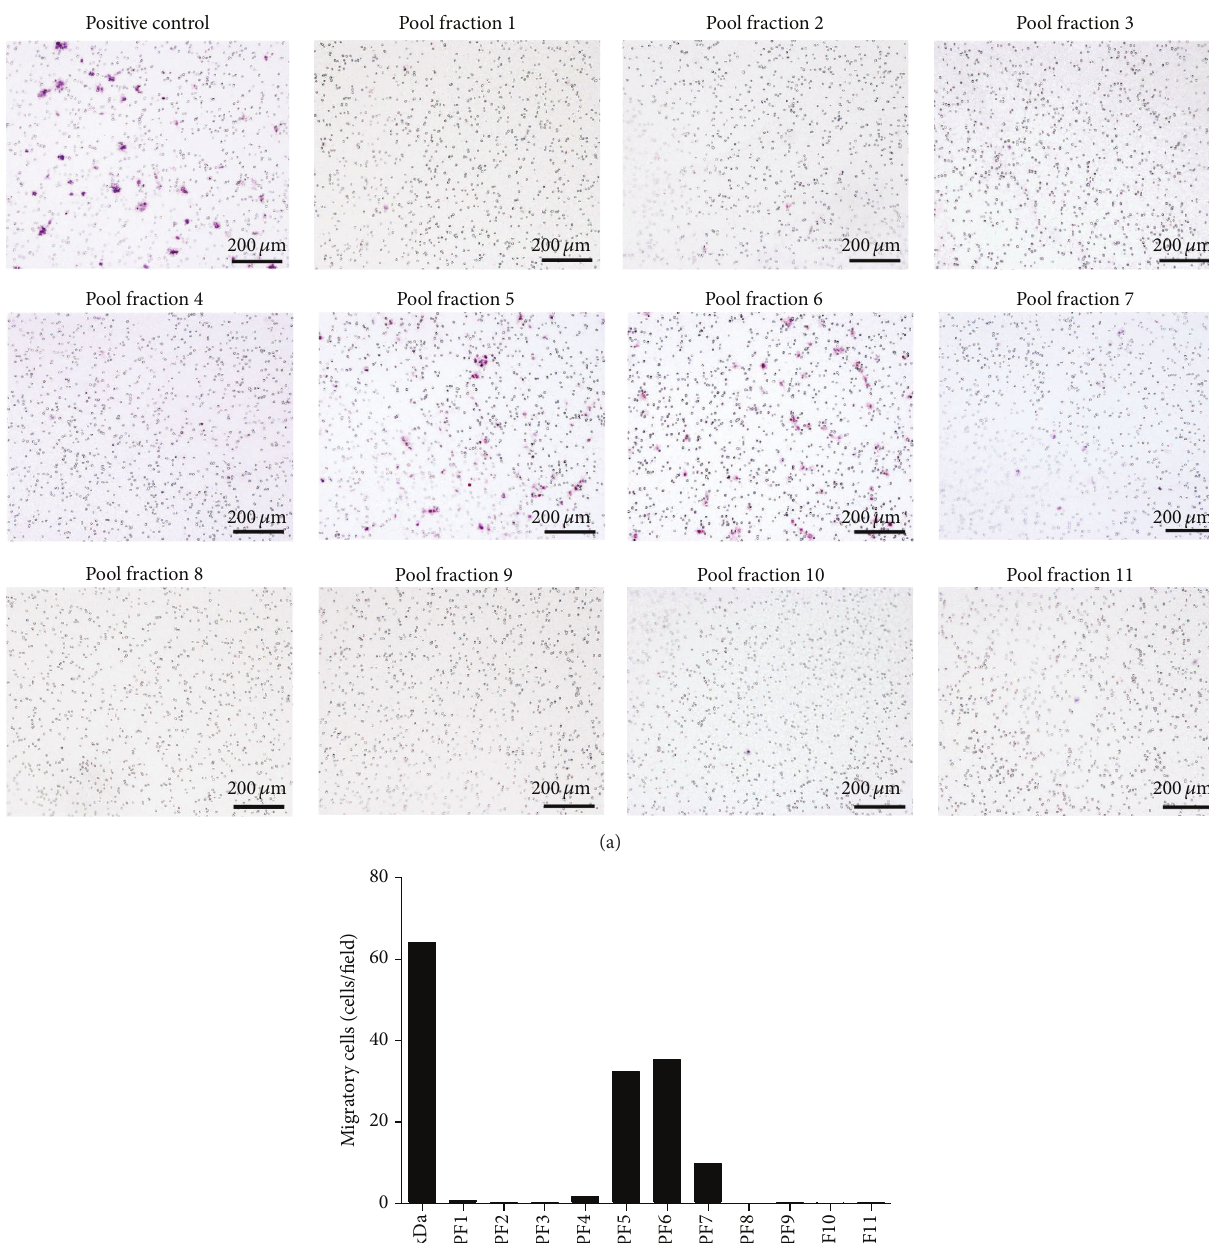
Figure 5: Effect of the 100 kDa subfractions on EPC migration. (a) Hematoxylin stained EPCs which migrated to the other side of membrane in response to soluble factors presented in 11 distinct subfractions (PF) of the 100kDa fraction of PL-MSCs conditioned medium (scale bar = 200 𝜇 m). (b) Number of EPCs which migrated in response to soluble factors presented in 11 distinct subfractions of the 100kDa fraction of PL-MSCs conditioned